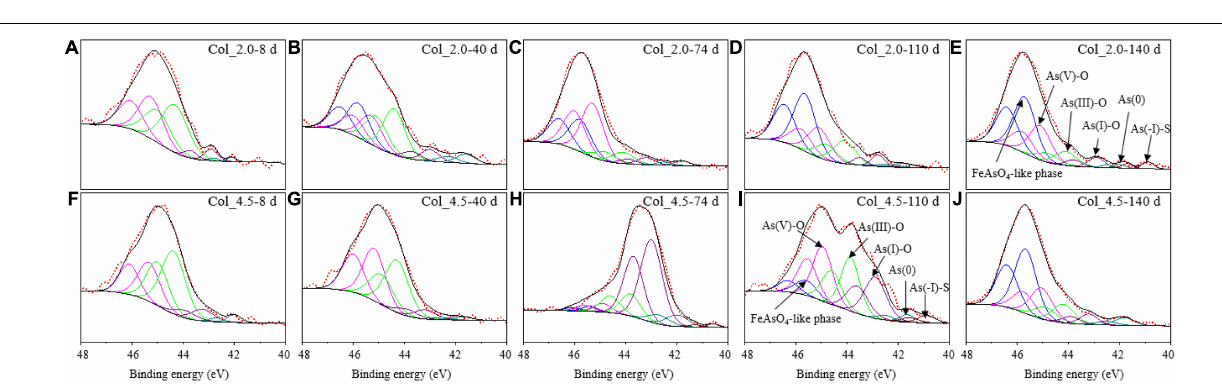
FIGURE 7 | XPS spectra for the surface As of bottom residues during cultivation with additions of 2.0 mM (A–E) and 4.5 mM (F–J) As(III) on days 8, 40, 74, 110, and